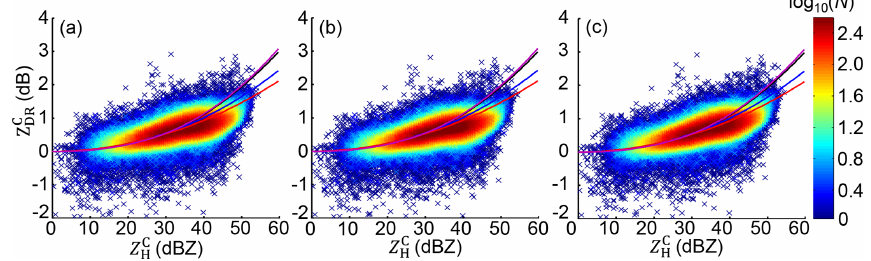
and Z C , utilizing ˆ Z DR estimated by (a) Eq. (11a) (the blue curve), (b) Eq. (11b) (the red curve), and DR H